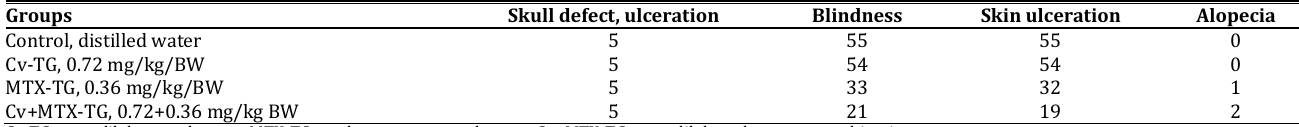
Table 6. The number of alive, stillbirth body weight of parturated pups of carvedilol, methotrexate alone and in combination Groups